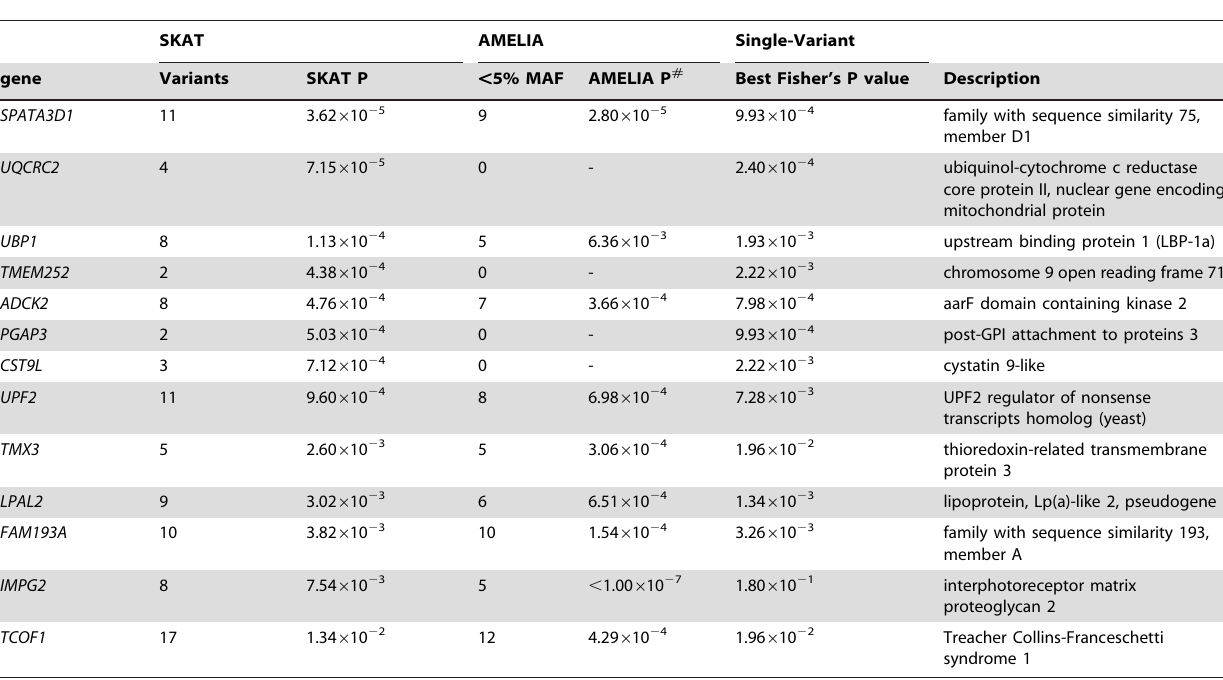
Table 3. SKAT and AMELIA analysis results using primary controls, ranked by SKAT P value.